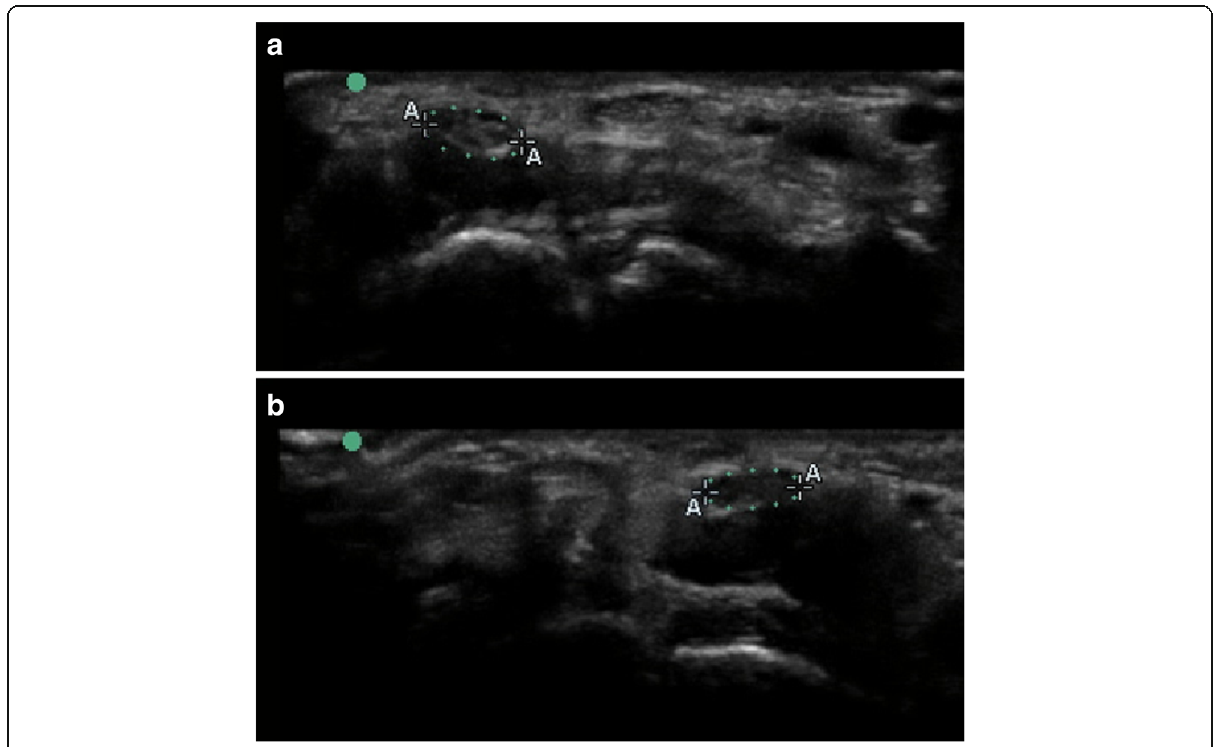
Fig. 1 Ultrasound transverse view of the patient ’ s wrist. a Left wrist (the palm of which suffered from numbness and tingling). b Right wrist. Dashed circles indicate the median nerves. The figure shows enlargement of the left median nerve compared to the right median nerve